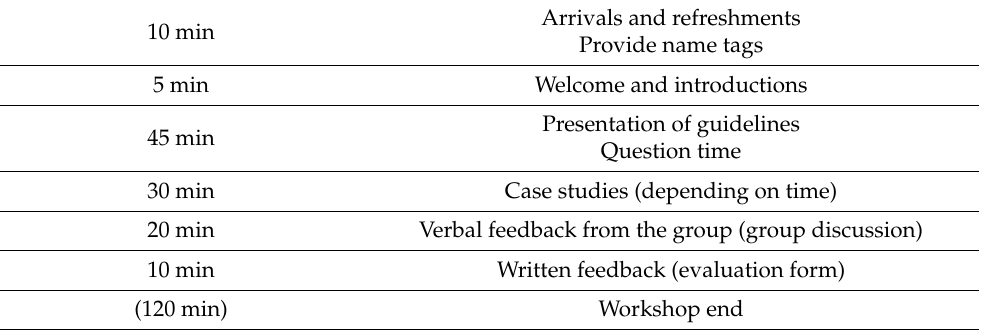
Table 1. Dissemination workshop